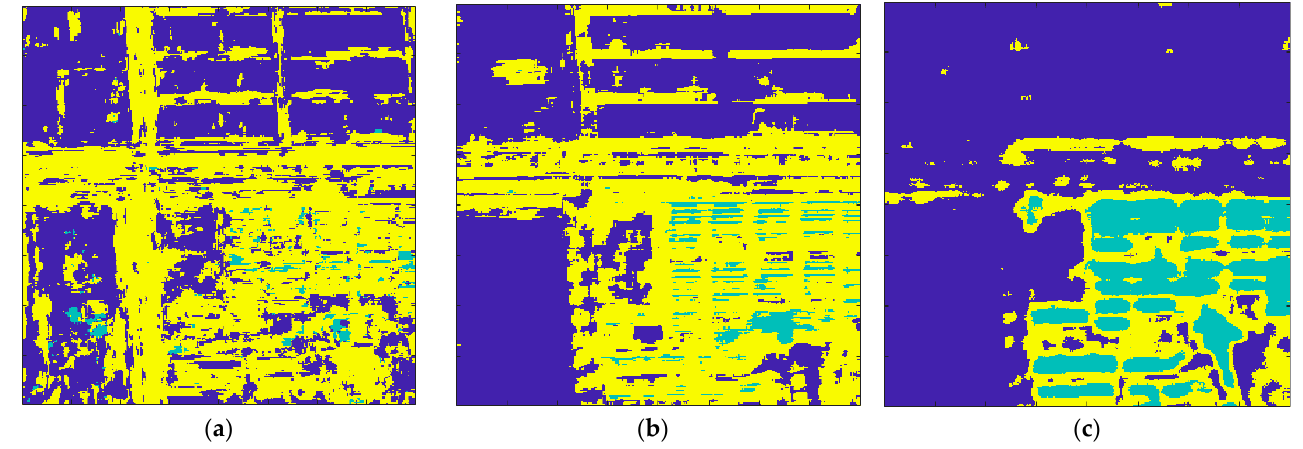
Figure 10. ( a ) C-band SAR classification results. ( b ) L-band SAR classification results. ( c ) P-band SAR classification results.